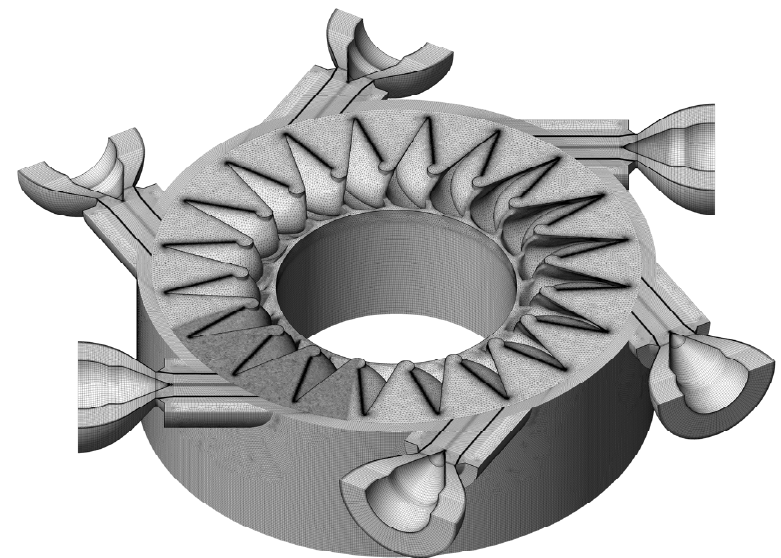
Figure 6. Numerical mesh of casing, nozzles, and the runner.